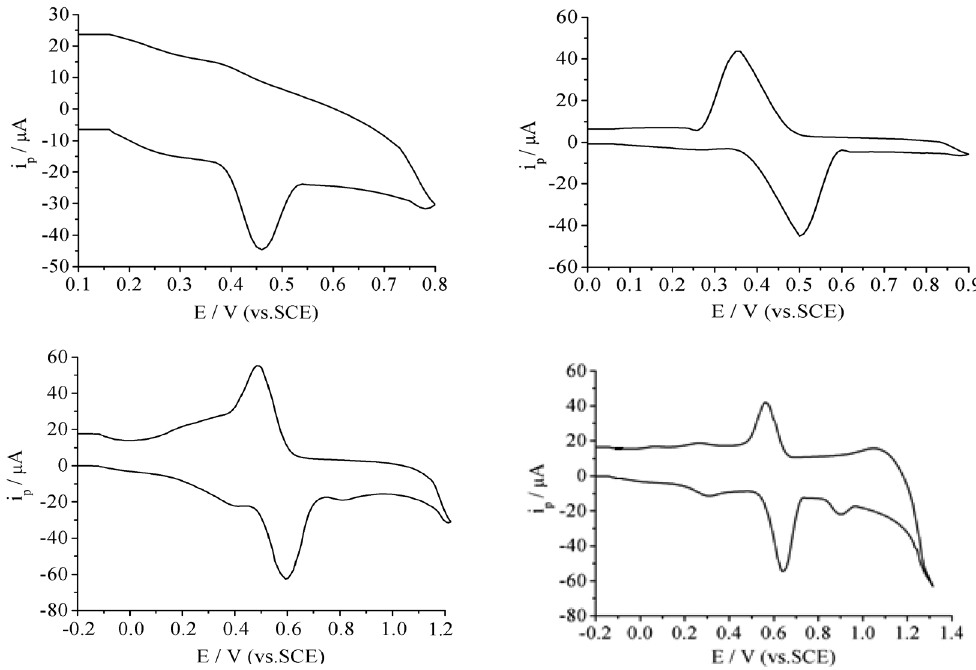
Figure 8: The cyclic voltammogram of four polyphenolic compounds.